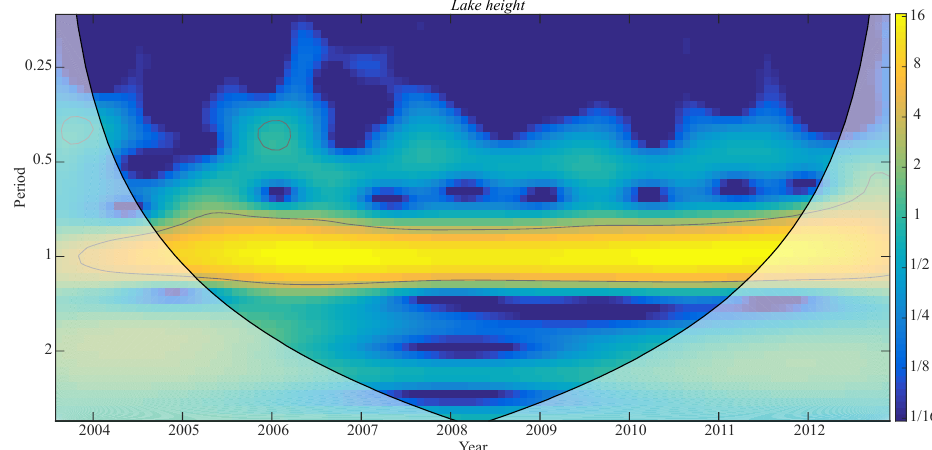
Figure 5. Same as Figure 3 for the Lake Chad water elevation